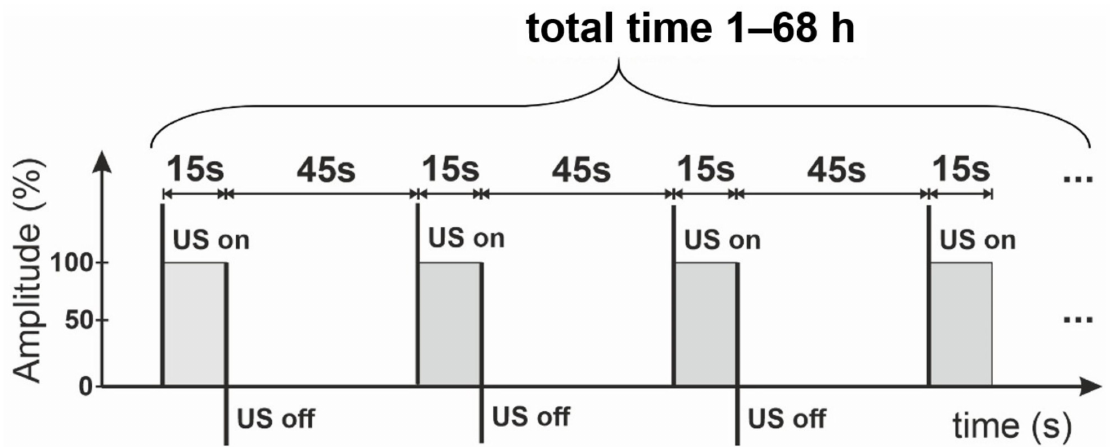
Figure 1. The sequence of ultrasonication (US) used for Xn-graphene oxide (GO) (X = 0, 1, 2, 3, 7, and 68) production. Note that the 15 s working intervals are followed by 45 s delays; X—the time of sonication represents the total proceeding